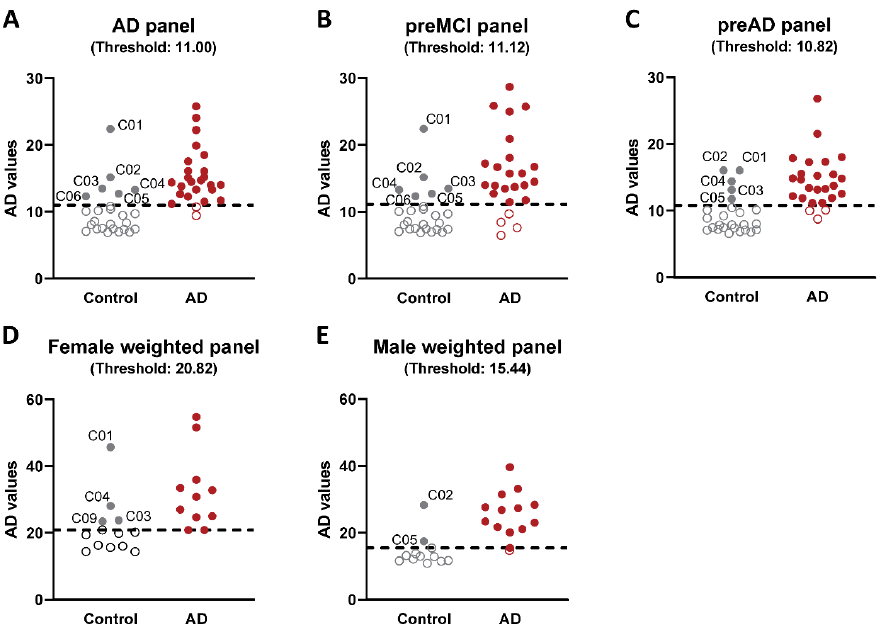
Figure 2. ROC ranking of control and AD cases with different antibody panels. Plot of cumulative biomarker levels of various different plasma samples from AD and control cases analyzed with different biomarker panels. Cutoff thresholds from ROC analyses shown as dotted lines. ( A ) Plot of cumulative biomarker levels of all samples from 25 control and 25 AD cases using the AD biomarker panel (A β —C6T, E1; tau—D11C, ADTau2, ADTau4, ADTau6; TDP-43—AD-TDP3). The panel detected 23 out of 25 AD cases and flagged 6 of the 25 controls (filled circles). ( B ) Similar plot of preMCI only samples from 24 AD cases and all samples from 19 unflagged control cases using the same biomarker panel in ( A ). The panel detected 20 out of 24 AD cases and flagged 6 out of 25 controls (filled circles). ( C ) Similar plot of preAD samples only from 25 AD cases and all samples from 20 unflagged control cases using the preAD biomarker panel (A β —C6T; tau—D11C, F9T, ADTau2, ADTau4, ADTau6; TDP-43—AD-TDP3). The panel detected 22 out of 25 AD cases and flagged 5 out of 25 controls (filled circles). ( D ) Similar plot of preAD samples only from female AD cases and samples from female unflagged control cases using the female-biased biomarker panel (A β —C6T, E1 ; tau— D11C, F9T, ADTau2, ADTau4, ADTau6 ; TDP-43— AD-TDP3 ) (biomarkers in bold were weighted double). The panel detected 11 out of 11 female AD cases and flagged 4 out of 13 female control cases (filled circles). ( E ) Similar plot of preAD samples only from male AD cases and samples from male unflagged control cases using the male-biased biomarker panel (A β — C6T , tau—D11C, F9T, ADTau2, ADTau4, ADTau6 ; TDP-43—AD-TDP3) (biomarkers in bold were weighted double). The panel detected 13 out of 14 male AD cases and flagged 2 out of 12 male control cases (filled circles).